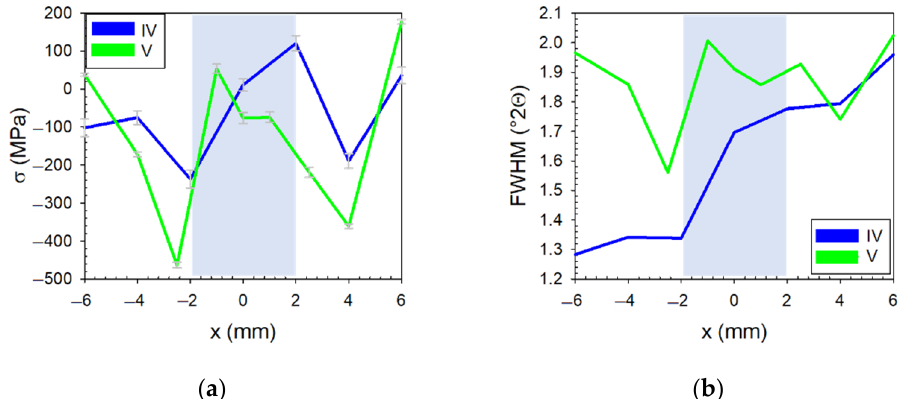
Figure 9. ( a ) Macroscopic residual stresses and ( b ) FWHM parameter of the circumferential weld in the axial direction. The blue area denotes the position of the circumferential weld [22].